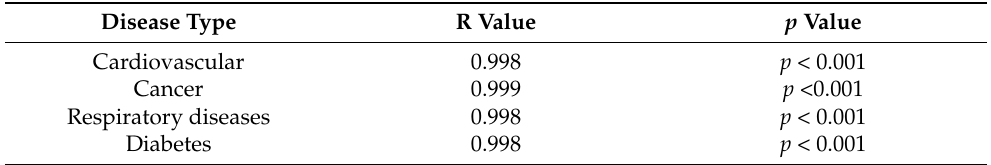
Table 4. Significance of the correlation between life expectancy and four major chronic non- communicable